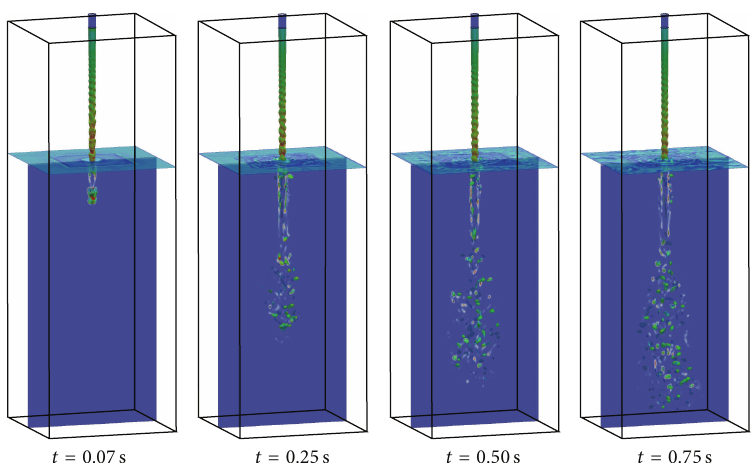
Figure 12: Time series of the plunging liquid jet for the simulation on the refined mesh using the reduced PBE and the dropSize switching